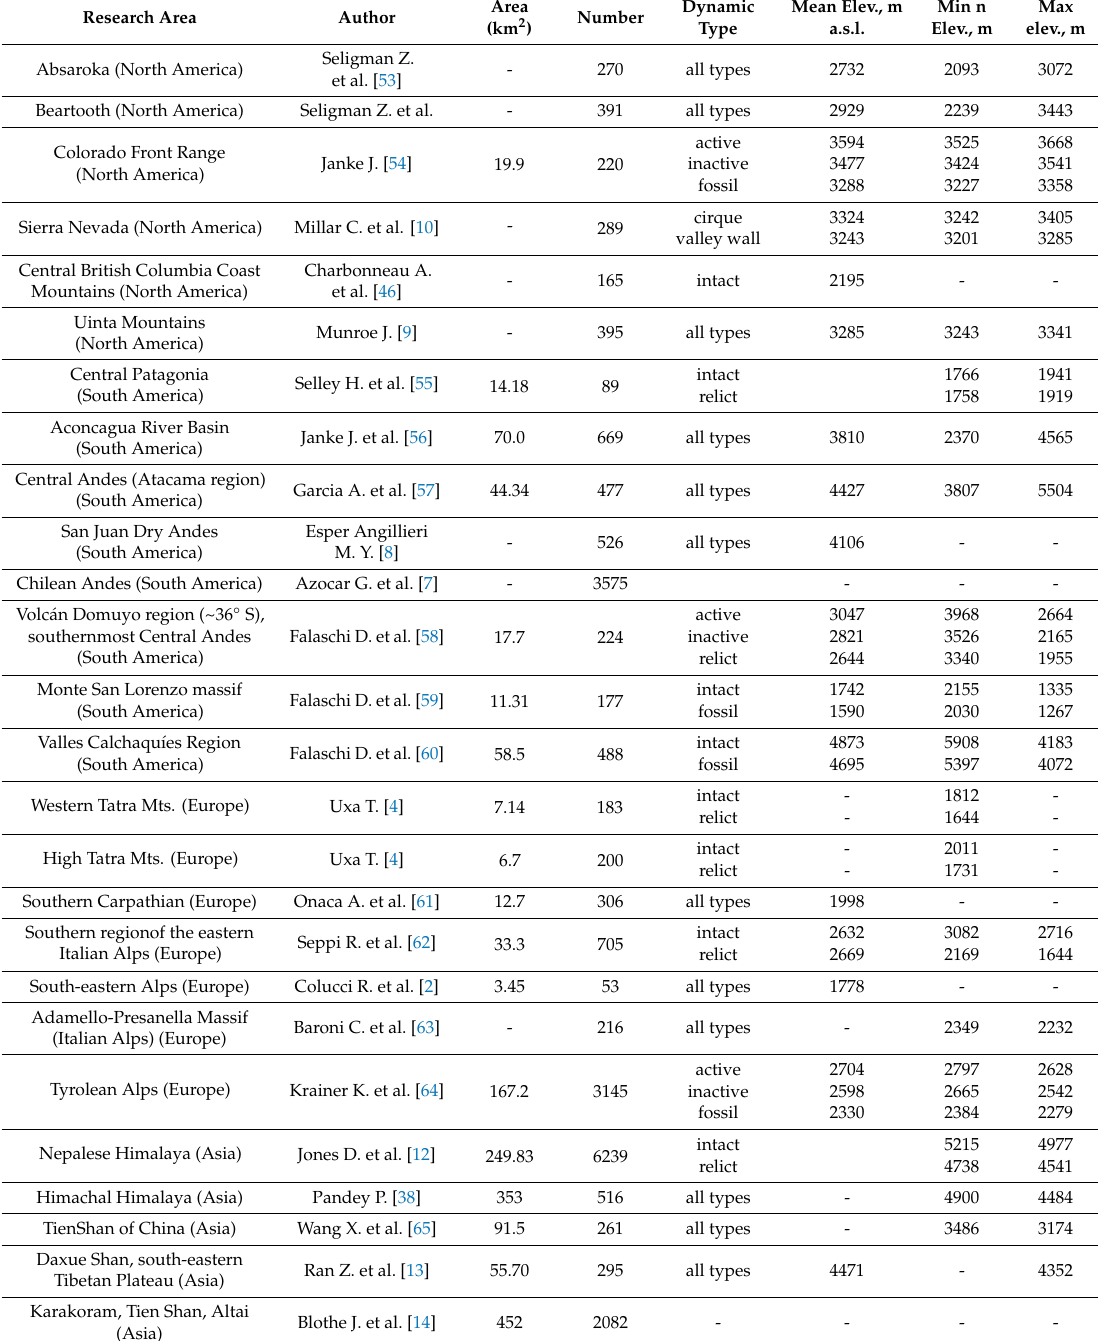
Table 6. Statistical Parameters of Rock Glaciers of the